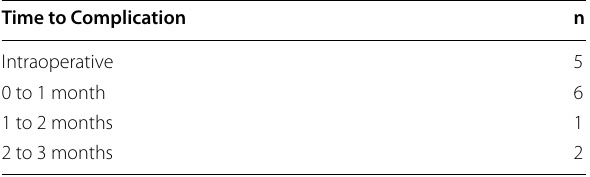
Table 3 Time to Pin-Site